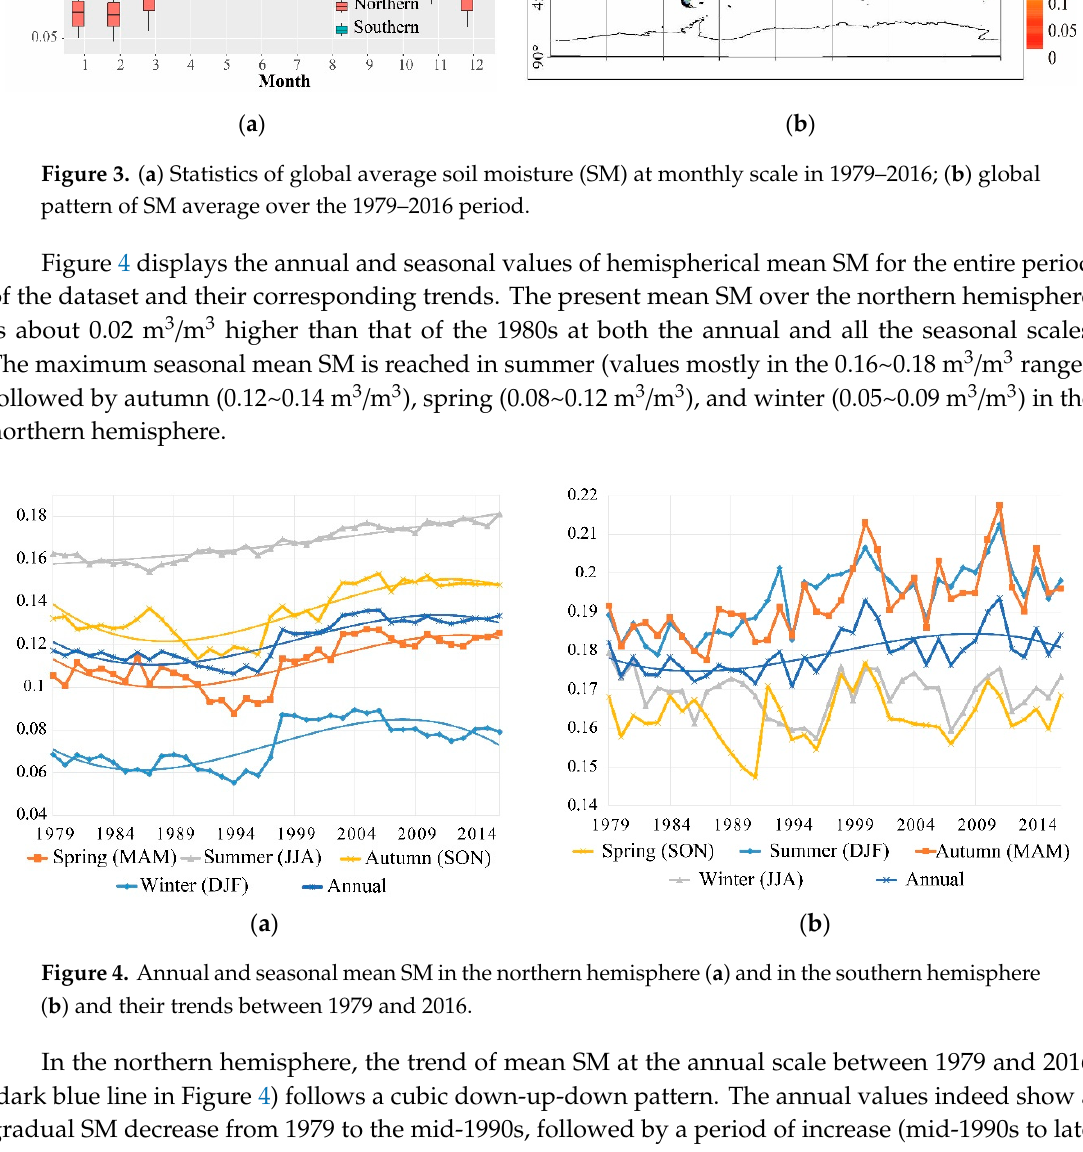
Figure 3. ( a ) Statistics of global average soil moisture (SM) at monthly scale in 1979 ‒ 2016; ( b ) global pattern of SM average over the 1979 ‒ 2016 period.